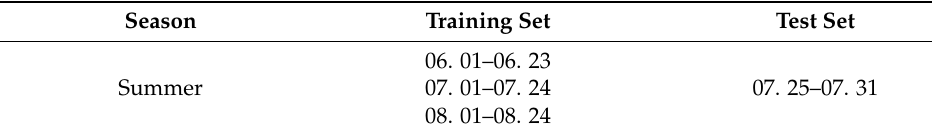
Table 3. Training set and test set of the GBM model trained by season.